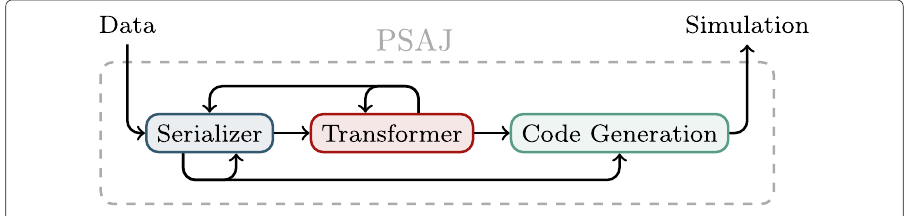
Fig. 4 Our envisioned usage of